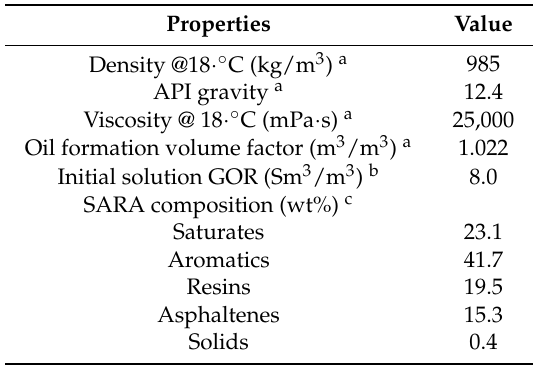
Table 2. Properties of the oil sample applied in this study. Properties